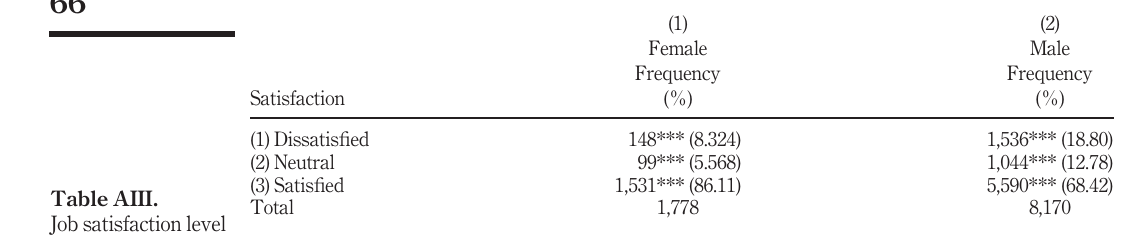
Table AIII. Job satisfaction level according to gender